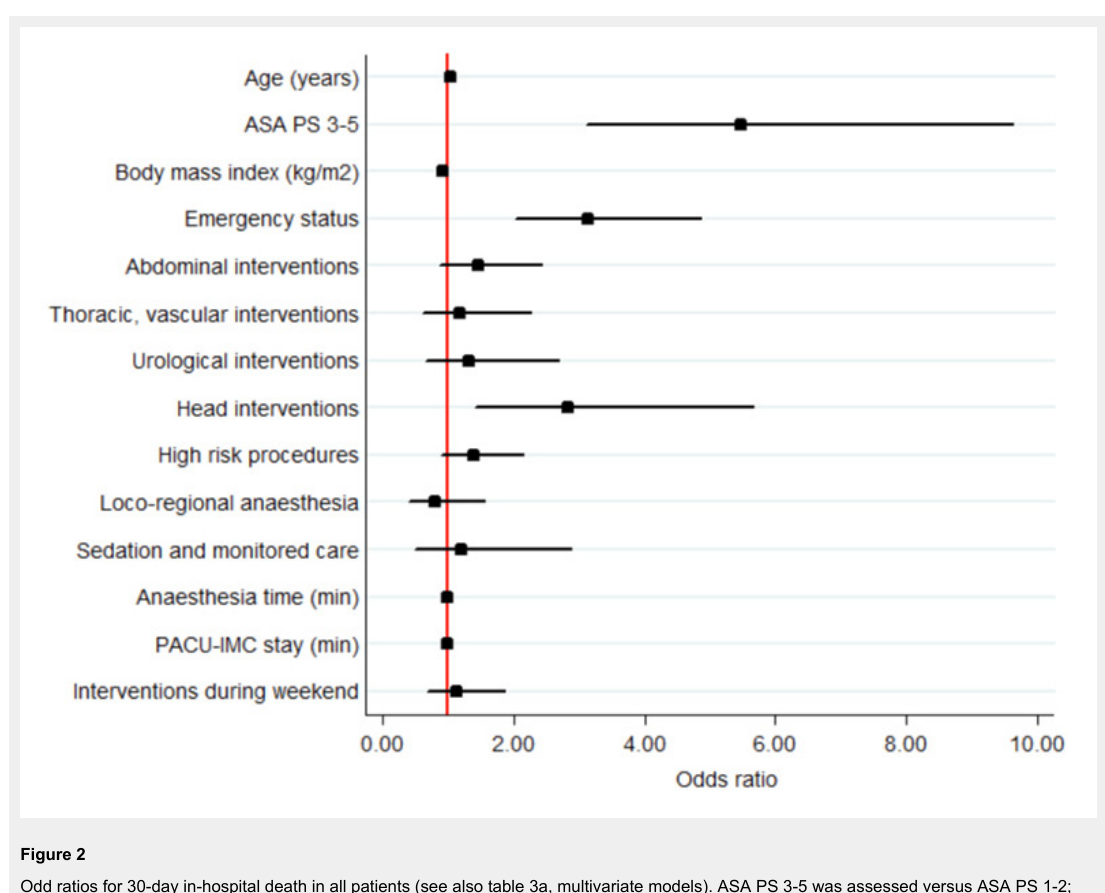
Figure 2 Odd ratios for 30-day in-hospital death in all patients (see also table 3a, multivariate models). ASA PS 3-5 was assessed versus ASA PS 1-2; emergency (nonelective) status versus elective; abdominal, thoracic – vascular, urological, head intervention versus orthopaedic; high-risk procedures versus low- and intermediate-risk procedures; locoregional anaesthesia, sedation and monitored care versus general and combined anaesthesia; interventions during weekend versus interventions during weekdays. ASA PS = American Society of Anesthesiologists Physical Status score; ICM = intermediate care unit; PACU = post anaesthesia care